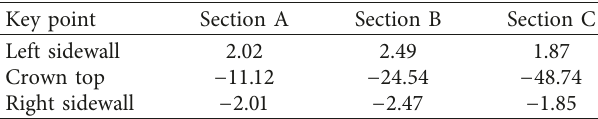
Geo. scale Figure 13: Plastic region at different lateral stress coefficients: (a) k Table 3: The stress of the key point in the sprayed concrete layer. Lateral stress coefficient k 0